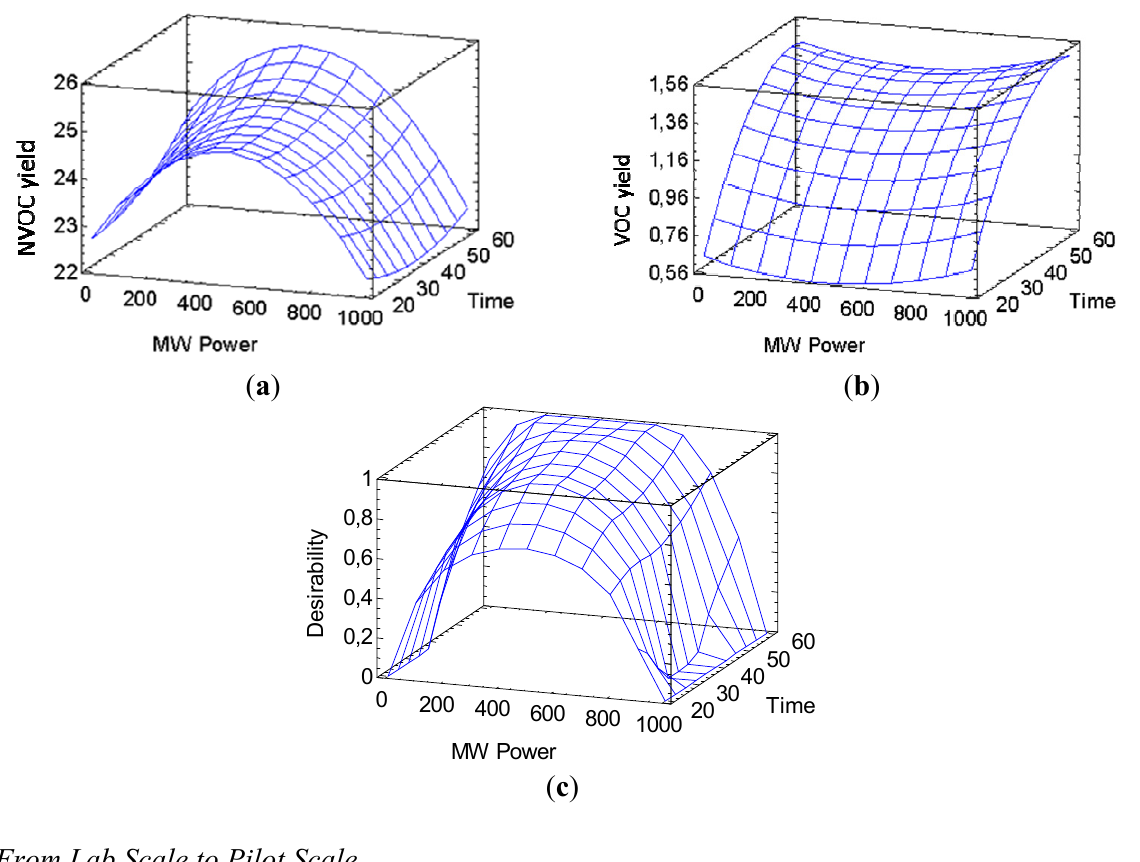
Figure 4. Optimization of microwave assisted extraction of boldo leaves in water: ( a ) NVOC yield (%) investigation in the multivariate study as a function of microwave power and time; ( b ) VOC yield (%) as investigation in the multivariate study as a function; ( c ) Response surface of optimization between yield and essential oil